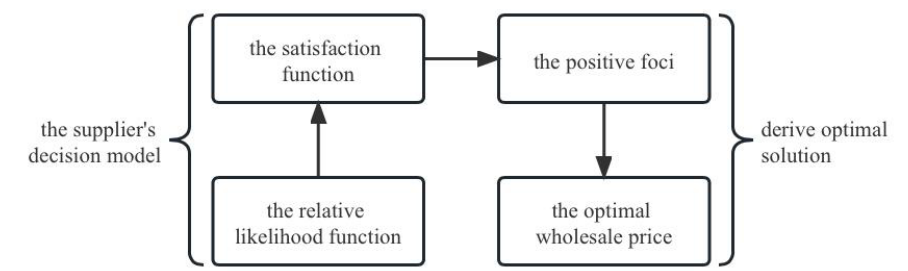
Figure 1. Method of modeling and solving.